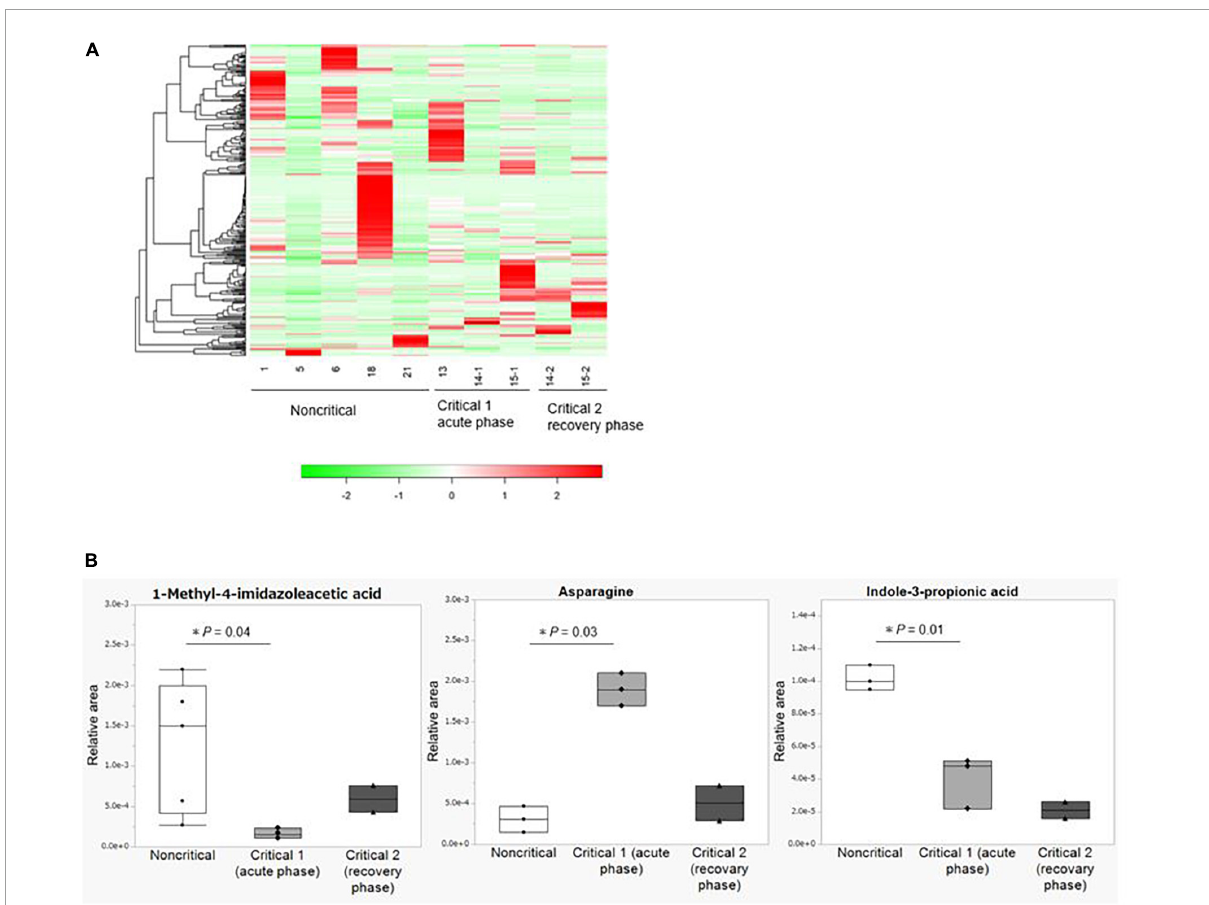
FIGURE3 Metabolome analysis of fecal contents from COVID-19 patients. (A) Hierarchical cluster analysis (HCA) of the metabolome data. From left to right: the non-critical group ( n = 5), the critical group in the acute phase (critical 1, n = 3), and the critical group in the recovery phase (critical 2, n = 2). (B) Fecal metabolites with significant differences between the non-critical and critical groups. From left to right: the non-critical group ( n = 5), the critical group in the acute phase (critical 1, n = 3), and the critical group in the recovery phase (critical 2, n = 2). Asparagine and Indole-3-propionic acid in the non-critical group were not detected in two of the five cases. Statistical analysis was performed by using Welch’s t -test. Statistical significance was accepted as P <